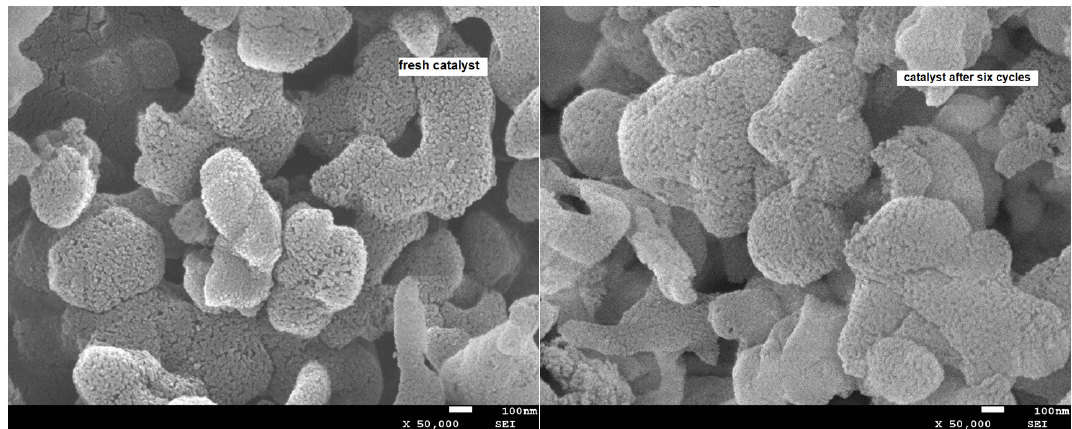
Figure 6. SEM images of catalyst MCM-41@ILLaCl 4 before and after reaction.